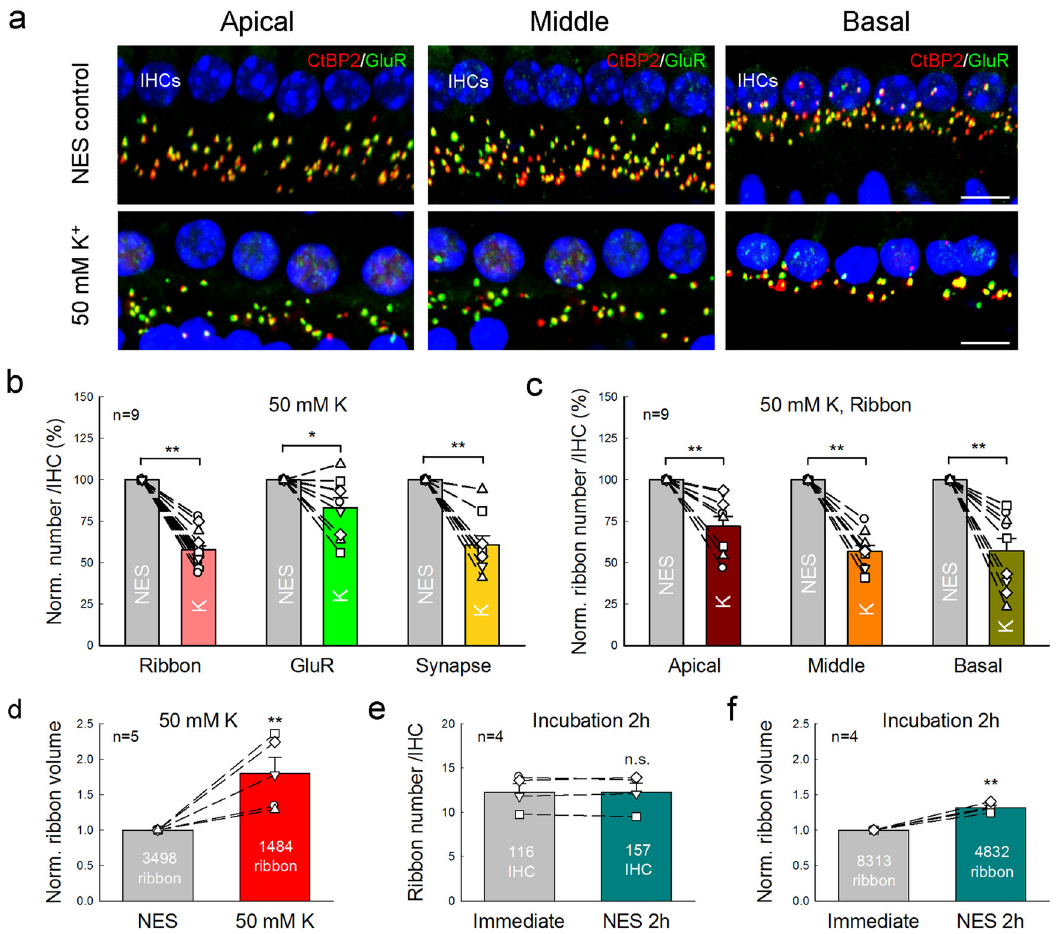
Fig. 1 High-K + induced IHC ribbon synapse degeneration. a Immuno fl uorescent staining for ribbon synapses at the IHC area in the apical, middle, and basal turns after incubation. Two cochleas of a mouse were incubated separately in the high-K + (50 mM) extracellular solution and in the normal extracellular solution (NES) for 2 h. Presynaptic ribbons are labeled by CtBP2 (red) and postsynaptic GluRs are labeled by green. Scale bar: 10 µ m. b Quantitative analyses of high-K + induced ribbon synapse degeneration at IHCs. Presynaptic ribbons, postsynaptic GluRs, and synapses per IHC pooled from all cochlear turns were averaged and normalized to those in the control cochlea of the same mouse with NES incubation. Dashed lines connected two same symbols represent data collected from two cochleas of the same mouse. N is the animal number. c K + -induced ribbon degeneration in the cochlear apical, middle, and basal turn. The ribbon numbers in the different turns were normalized to those in the corresponding turn in the control cochlea of the same mouse. d High-K + induced ribbon swelling. The volume of labeling puncta for CtBP2 were measured. The data pooled from all cochlear turns were averaged and normalized to that in the control cochlea of the same mouse. Total numbers of measured ribbons are presented within the bars. N is the animal number. e , f Incubation procedure has no effect on ribbon degeneration. One cochlea was immediately fi xed after isolation and stained for CtBP2 and another cochlea of the same mouse was incubated in NES for 2 h and then fi xed for staining. Dashed lines connected two same symbols represent data collected from two cochleas of the same mouse. Data were pooled from all cochlear turns. Numbers in the bars represent the total numbers of accounted IHCs and measured ribbons. N is the animal number. * P < 0.05, ** P < 0.01, paired t -test, two-tail for all